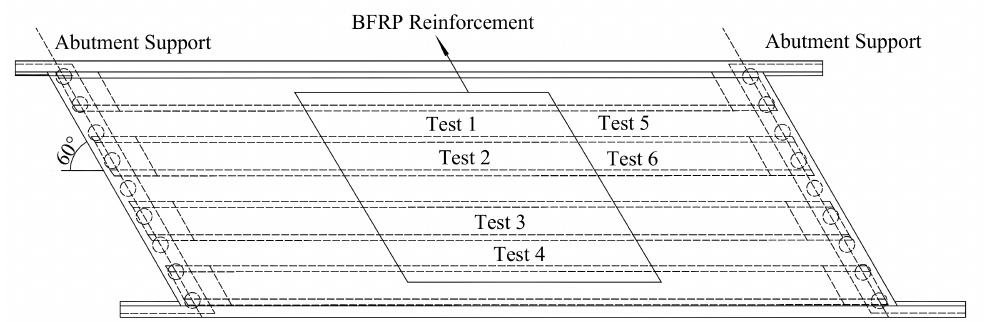
Figure 2. Test area of Thompson Bridge.